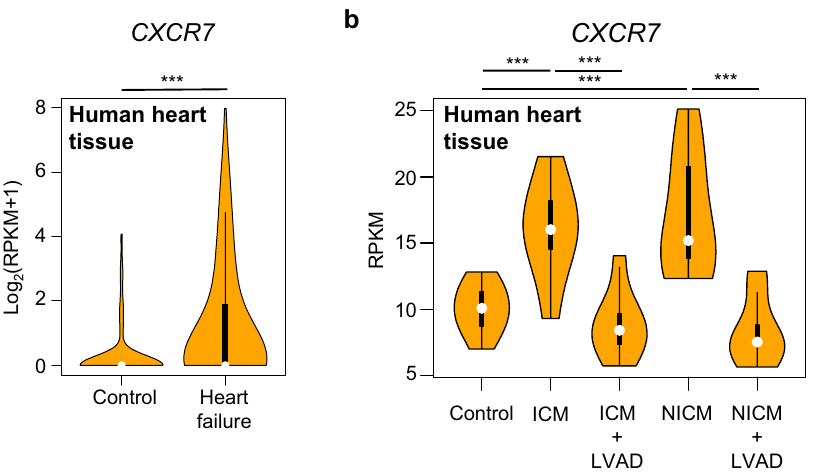
Figure 5. CXCR7 expression in cardiomyocytes is increased in heart failure patients. ( a ) Violin plots of CXCR7 mRNA expression based on single-cardiomyocyte RNA-seq of human heart specimens obtained from control subjects (n = 156) and patients with heart failure (n = 678). Significance was calculated by the Mann–Whitney test; *** P < 0.001 ( b ) Violin plots of CXCR7 mRNA expression based on bulk RNA-seq of human failing hearts before and after LVAD implantation. Analysis was performed using publicly available data 20 . Significance was calculated by ANOVA followed by the Bonferroni procedure; *** P < 0.001. ICM, ischemic cardiomyopathy; NICM, non-ischemic